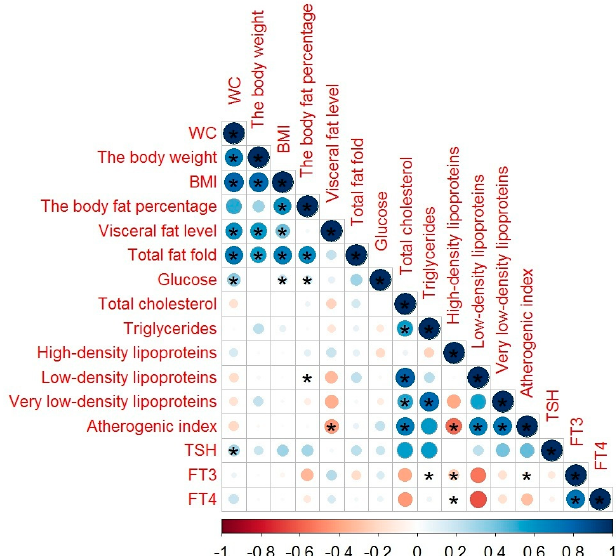
Figure 3. The correlation between body fat parameters, glucose and lipid profiles, TSH, and THs levels in general hospital inpatients with MetS: in this figure, red and blue circles mean negative and positive correlations, respectively; the size and color intensity of circles are proportional to the correlation coefficient; * p -value < 0.05; in the bottom, the legend of color intensity shows the rate of correlations and the corresponding relations.